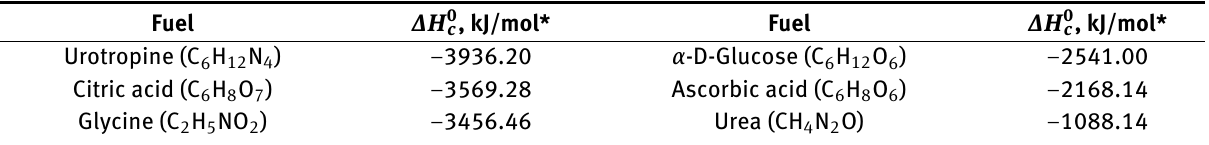
Table 1: Standard enthalpy of combustion of fuels (solid-state) Fuel ∆H 0 c , kJ/mol* Fuel ∆H 0 c , kJ/mol* Urotropine (C 6 H 12 N 4